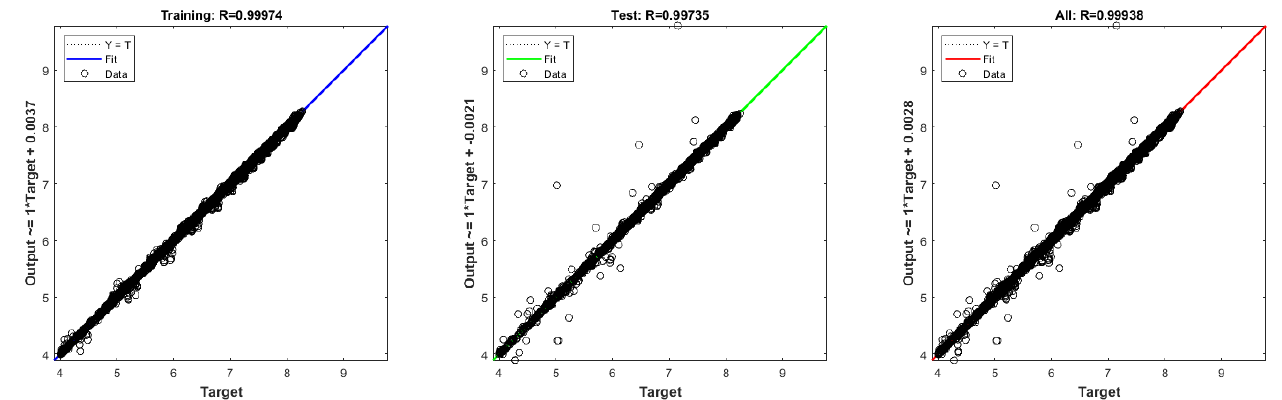
Figure 9. Performance analysis of the predicted